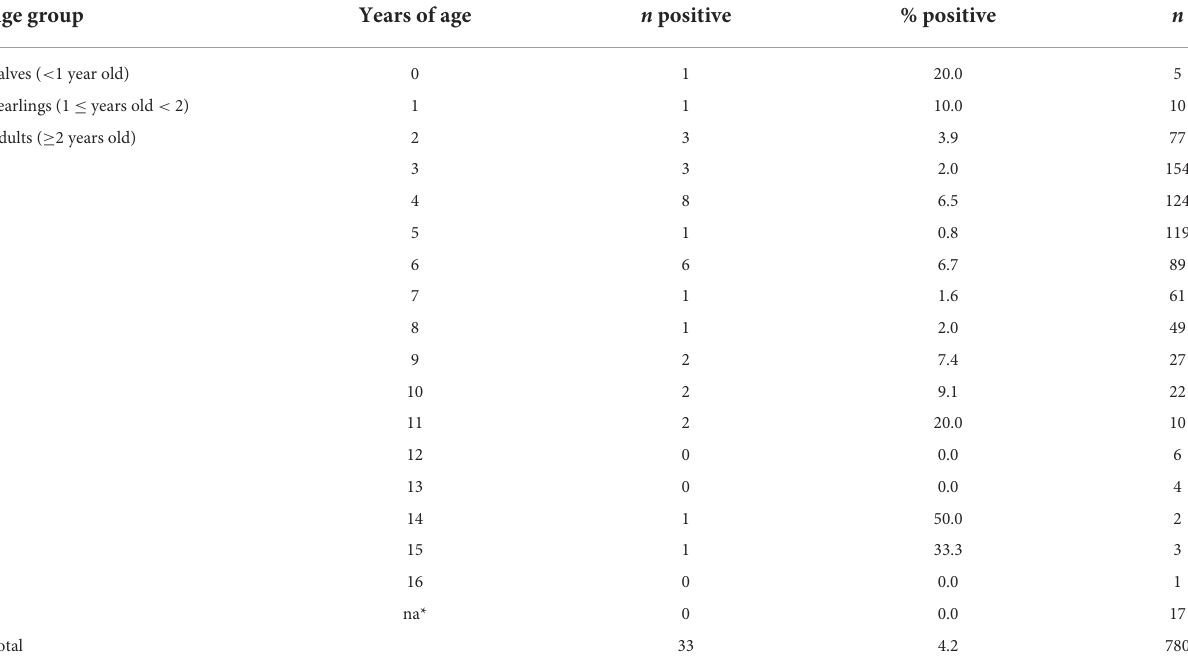
TABLE 1 Age group structure of sampled female cattle ( n = 780) and serological status for N. caninum , * only age group is known (i.e., adults), date of birth was not recorded. Age